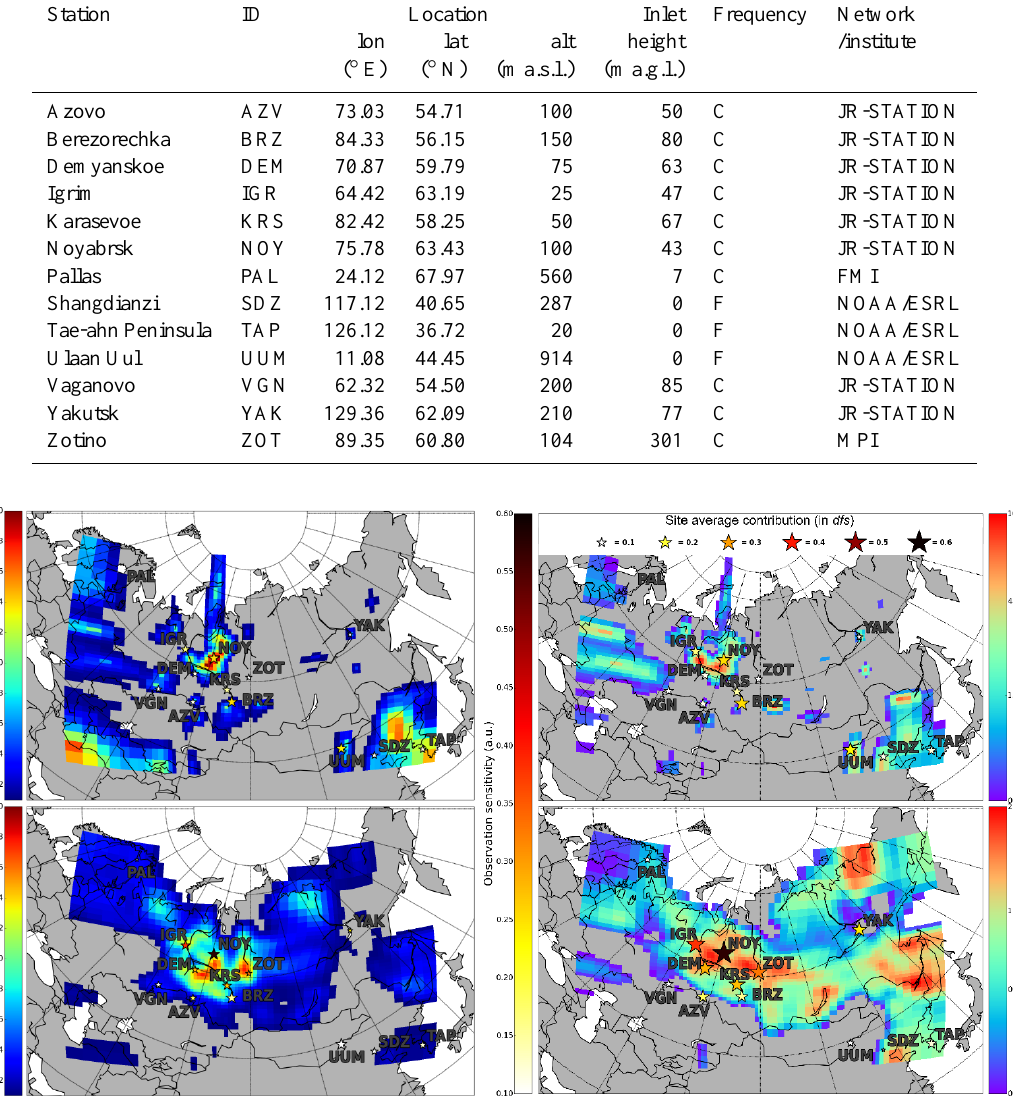
Figure 3. Maps of the constraints on the fluxes (top: anthropogenic fluxes; bottom: wetland emissions) from the observations in the inversion. (Left column) Constraints on the fluxes (arbitrary units; prefect constraint = 1) as calculated from the influence matrix (see Sect. 2.3.1). (Right column) Non-constrained fluxes as computed from the vector (cid:15) defined in Eq. (4b) of Sect. 2.3.1 in gCH 4 m − 2 yr − 1 . In the four panels, the coloured stars represent the sensitivity of the inversion (for each flux type) to observation sites as defined by the average of individual observation weights ω as defined in Eq. (4a) of Sect.